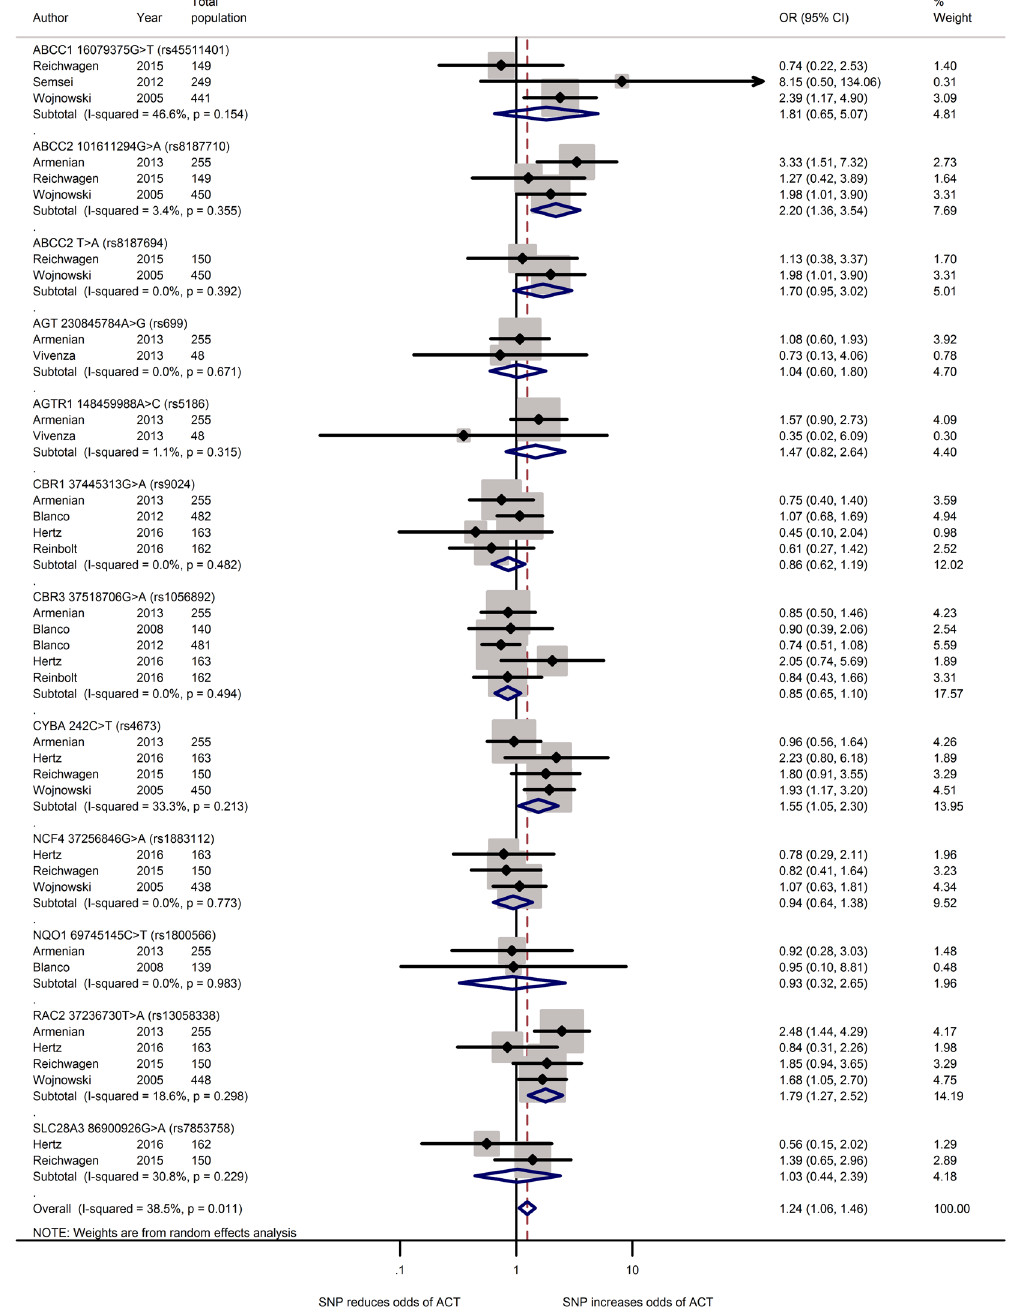
Figure 3. Forest plot of meta-analysis for 12 SNPs. Three variants, ABCC2 rs8187710, CYBA rs4673 and RAC2 rs13058338, are significantly increased the odds for